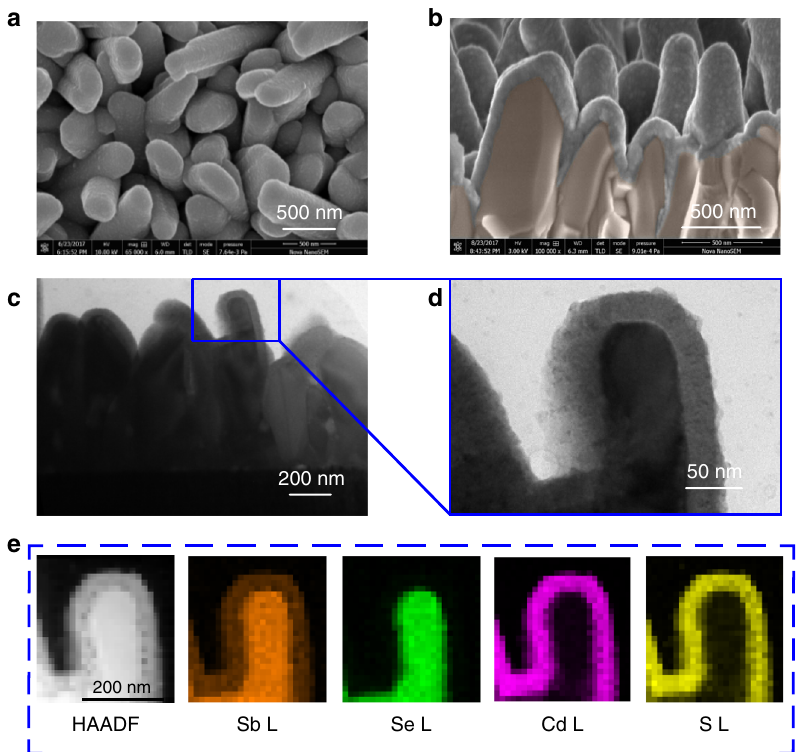
Fig. 5 Characterization of CdS/Sb 2 Se 3 junction interface. a , b Top-view ( a ) and cross-sectional ( b ) SEM images of CdS buffer deposited on Sb 2 Se 3 nanorod arrays. c – e TEM ( c , d ) and HAADF-STEM image and energy-dispersive spectroscopy elemental mapping ( e ) of the CdS/Sb 2 Se 3 junction interface. Elements detected: Sb L, Se L, Cd L, and S